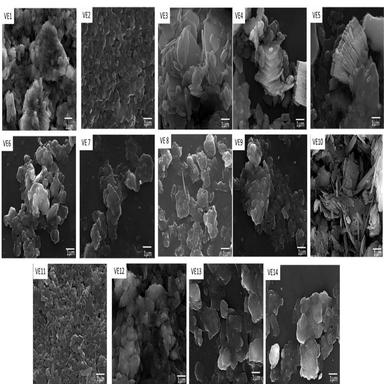
Selected SEM microphotographs of the studied samples.